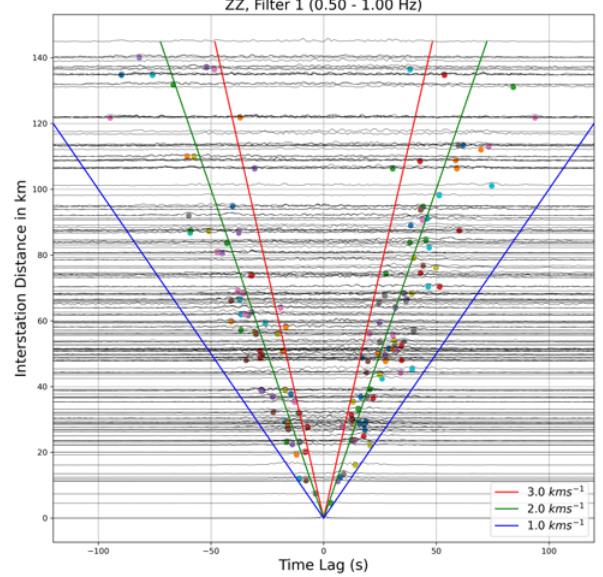
Figure 2: Distance plot for frequencies between 0.5 and 1 Hz, showing lag times on horizontal axis and intersta- tion distances on vertical axis. Solid lines are the theo- retical velocities and the coloured points represent the maximum correlation for each pair of stations.